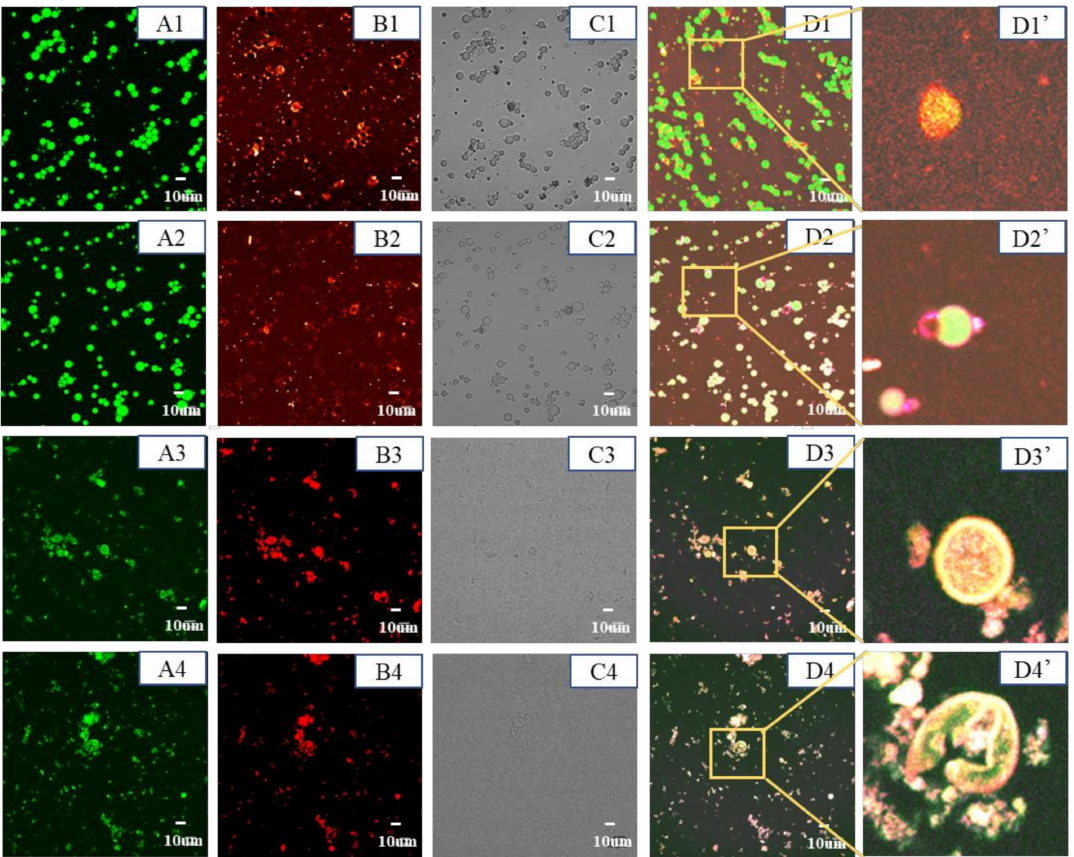
Figure 8. Microstructural analysis of in vitro simulated digestion of the CaCO 3 S/O/W emulsions. (A, Oil phase was stained with Nile red, excitation at 488 nm; B, Protein phase was stained with Nile blue, excitation at 635 nm (ii); C, bright field view; D, combined image; D’, high